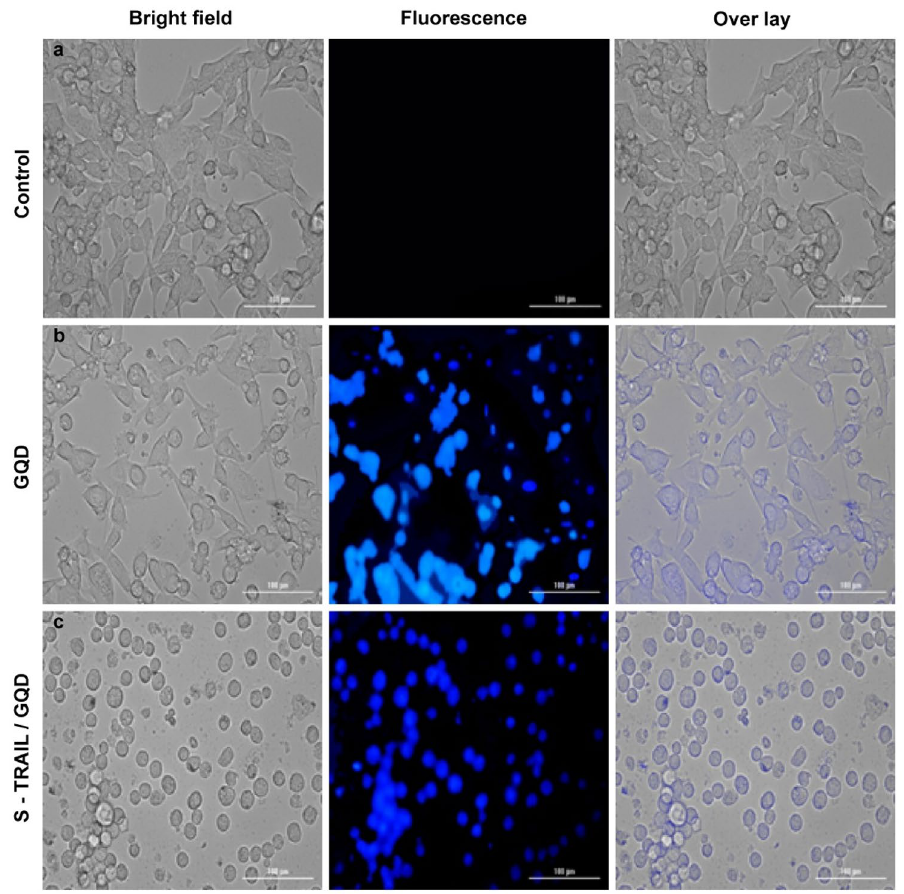
Figure 9. Fluorescence microscopy images of HT-29 cells ( a ) untreated ( b ) treated by GQDs and ( c ) treated by S-TRAIL/GQD for 24 h. In each panel from the left, first image is the bright field, the second image is the fluorescence and the third one is the overlay image of the first and the second